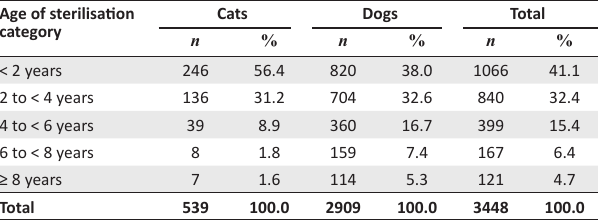
TABLE 4: The overall age at sterilisation according to species of pet. Age of sterilisation